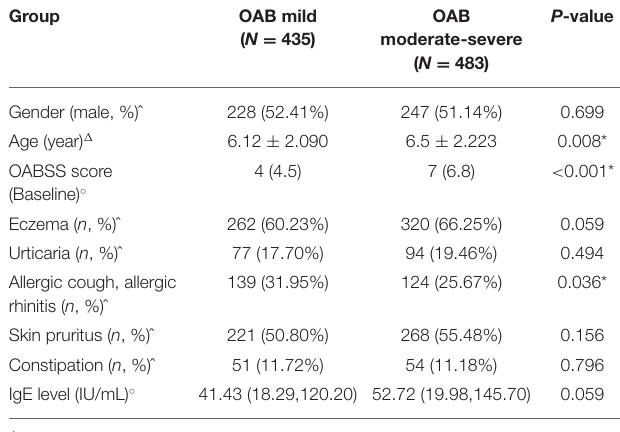
TABLE 3 | Comparison among groups with OAB different severities. Group